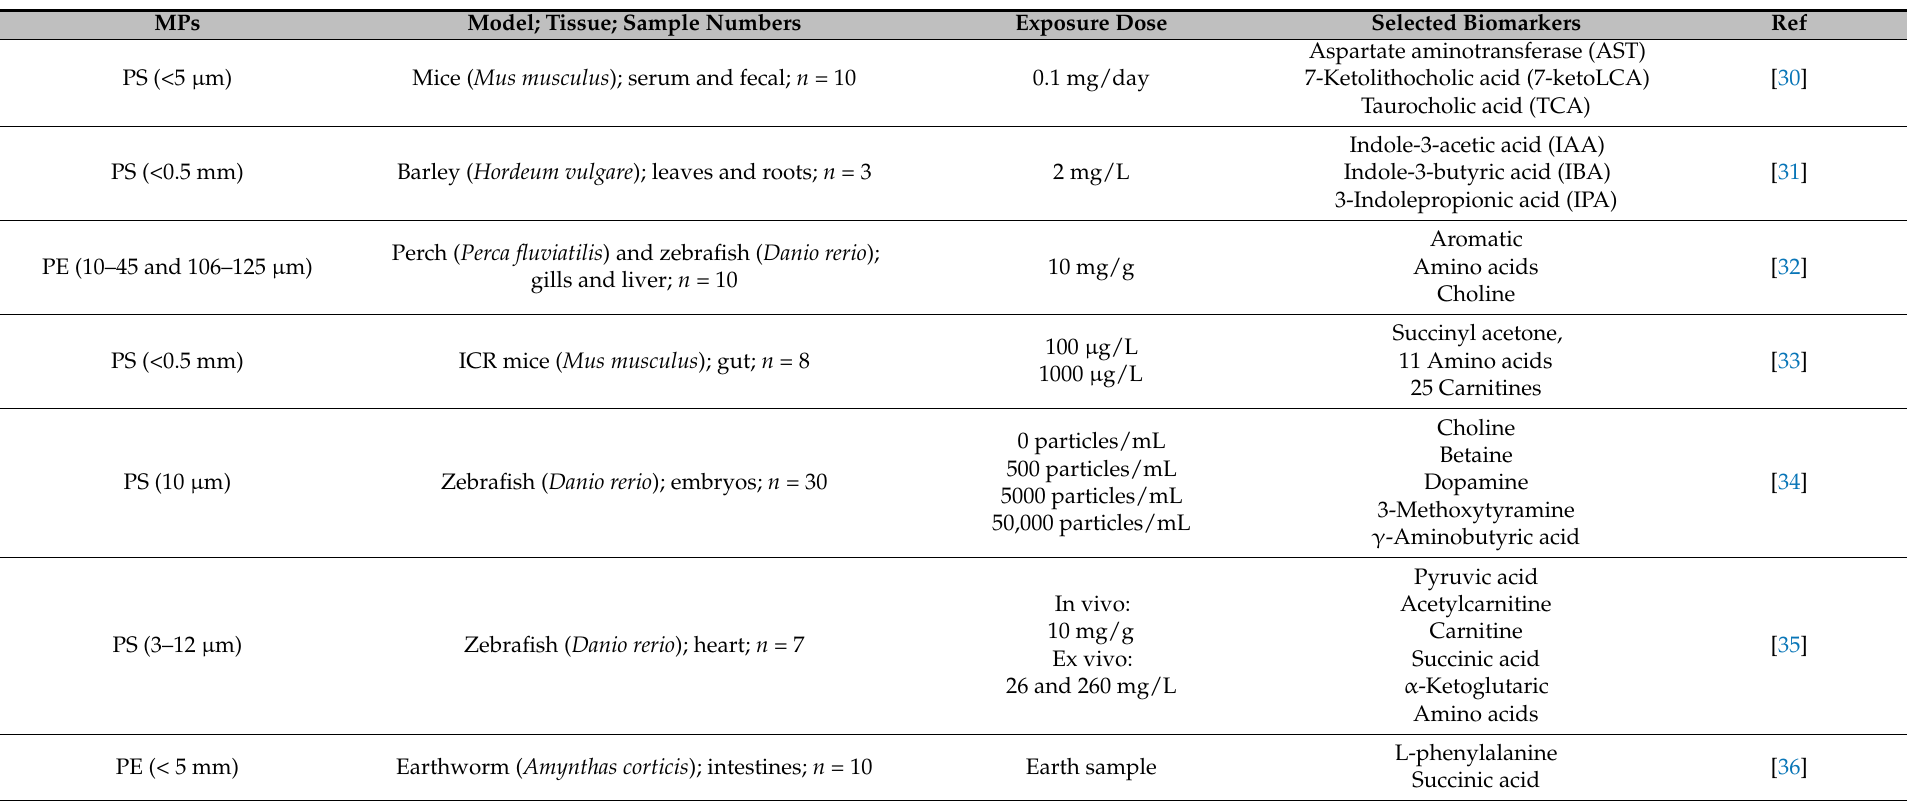
Table 1. The MPs, model, dose, and selected biomarkers of the studies cited above for MPs-induced targeted